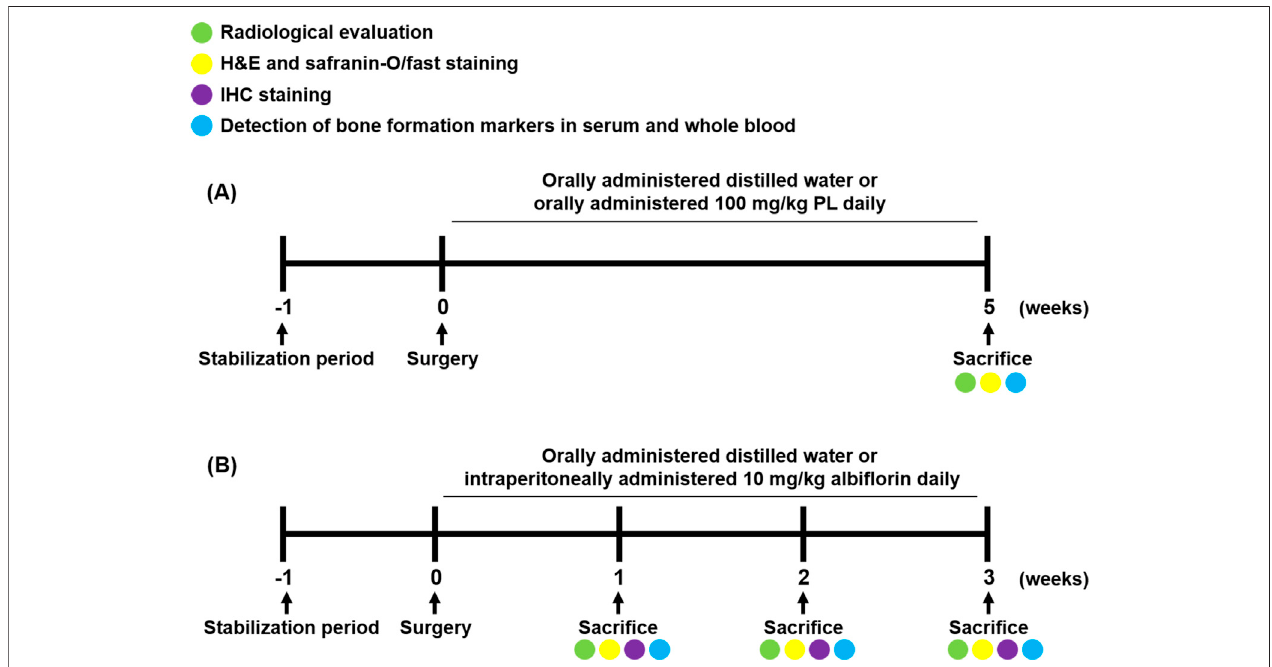
FIGURE1| Scheduleoffracture-inducedanimalexperimental. (A) ExperimentaldesigntoinvestigatetheeffectofPLonfracturerecovery. (B) Experimentaldesign to demonstrate the process of albi fl orin on fracture healing.